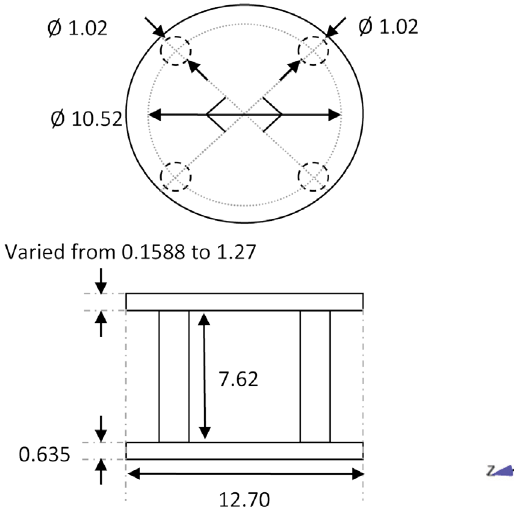
Fig. 7. Drawing of a simple structure consisting of two circular plates joined by four legs (dimensions in cm).